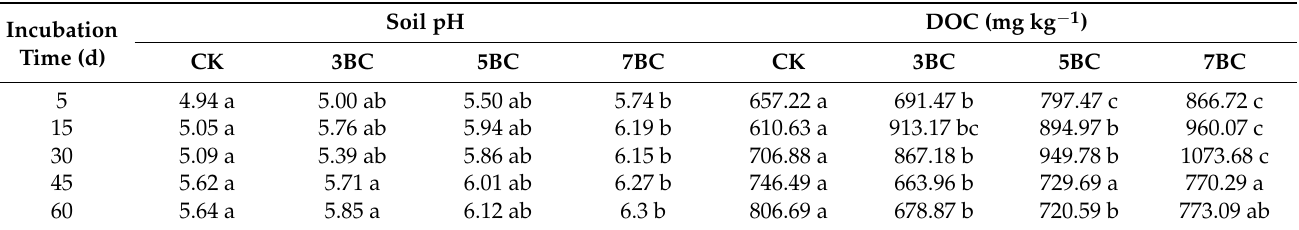
Table 1. Changes in pH and DOC of soil amended with biochar at 300 ◦ C, 500 ◦ C and 700 ◦ C pyrolysis